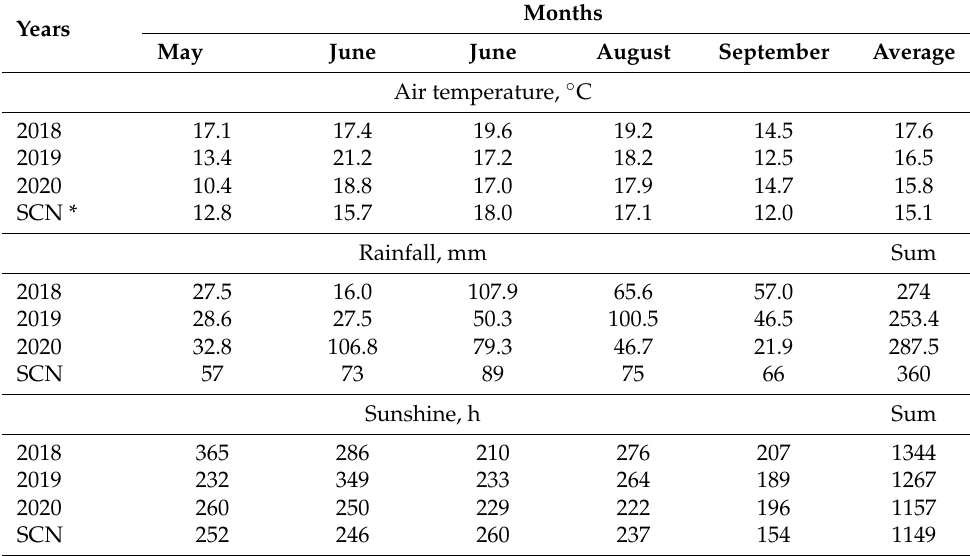
Table 1. Weather conditions during the rosehip vegetation period in 2018, 2019 and 2020 (Šiauliai meteorological station,